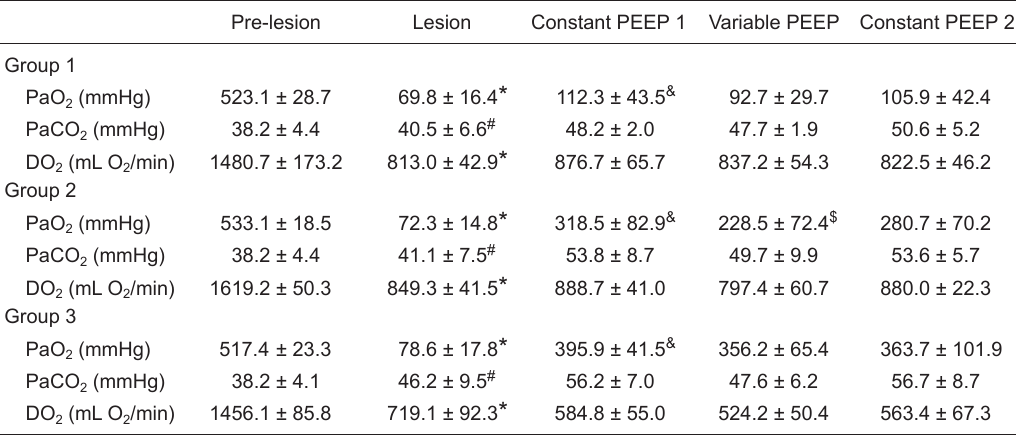
Table 2. Gas exchange in groups studied in all phases of the